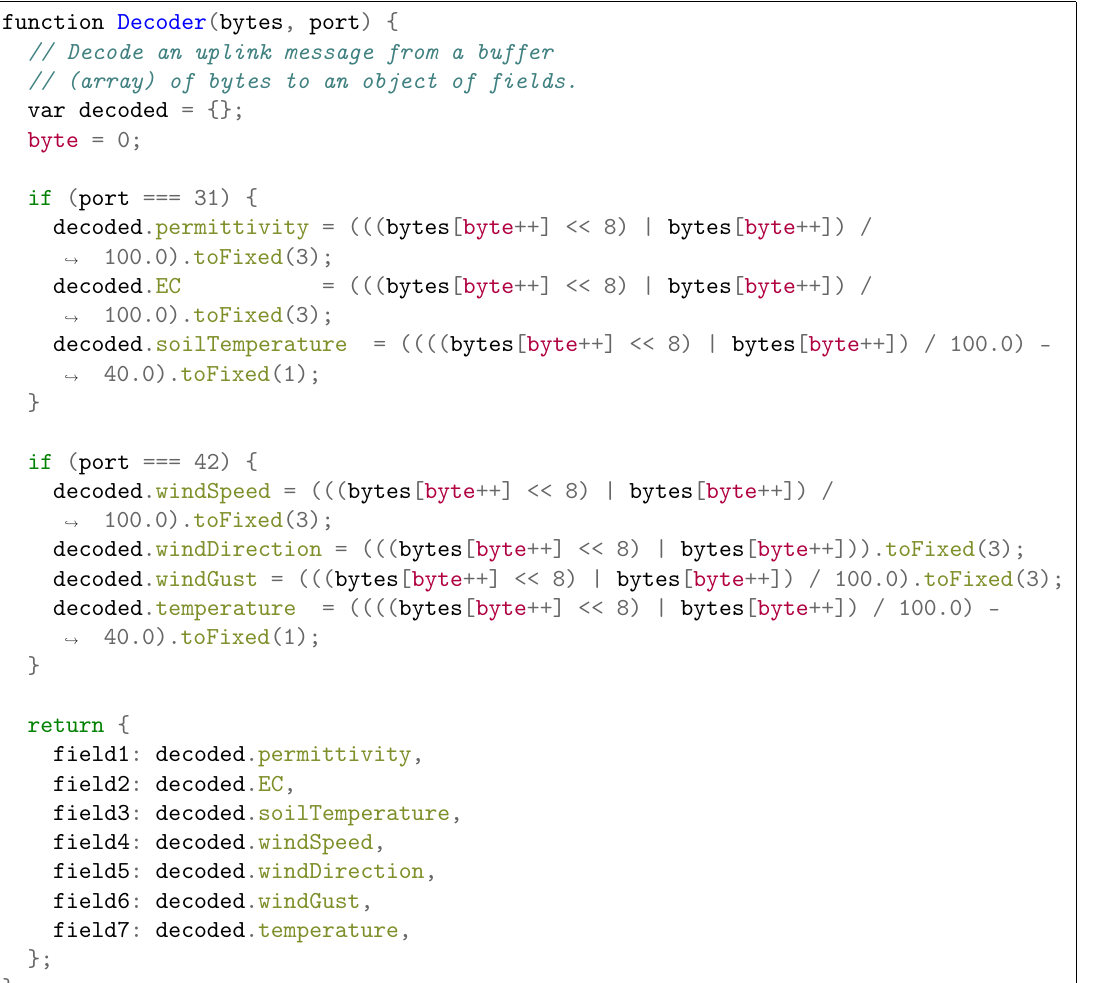
Figure 7. Example of one decode function at TTN.